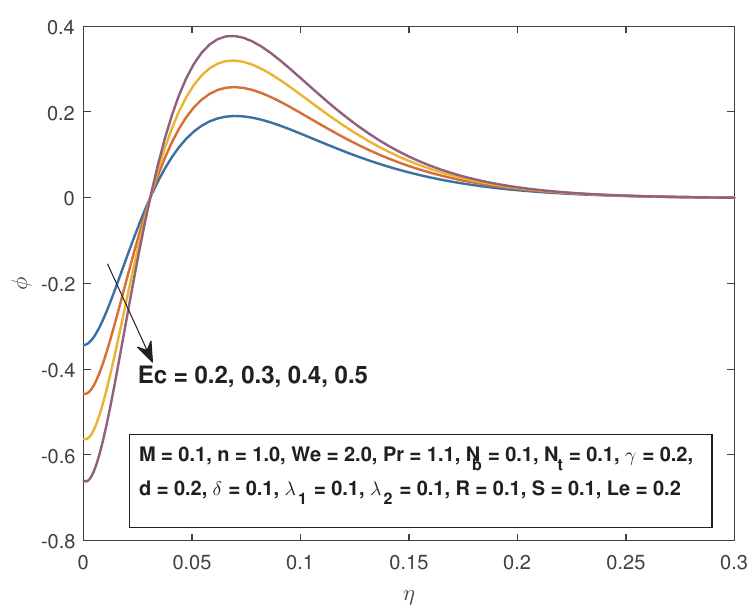
Figure 18. Influence of Ec on the fluid concentration.